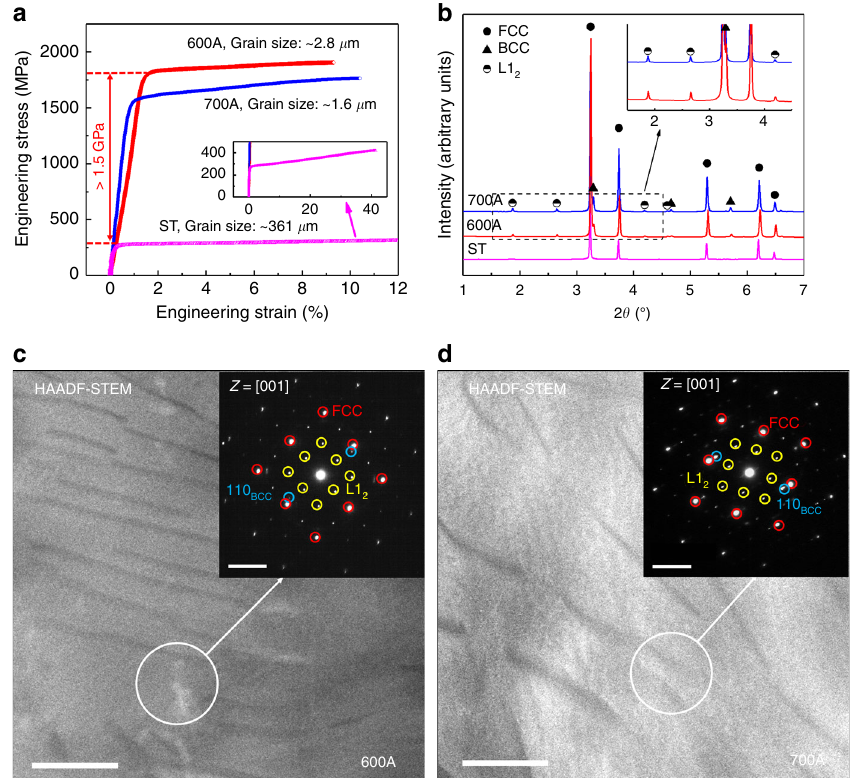
Fig. 2 Mechanical properties and phase constituent of our alloy prepared under various processing conditions. a Tensile engineering stress – strain curves showing remarkable increases in strength occurring after cold-rolling and ageing (>1500 MPa for 600 A and ~1200 MPa for 700 A compared with the ST sample). b HEXRD spectra showing that the aged samples contain FCC, L1 2 , and BCC phases, whereas the ST sample is a single-phase FCC alloy. c , d HAADF-STEM images of 600 A and 700 A, respectively. Scale bar, 200 nm. The SAED patterns in the insets verify the phase composition in the